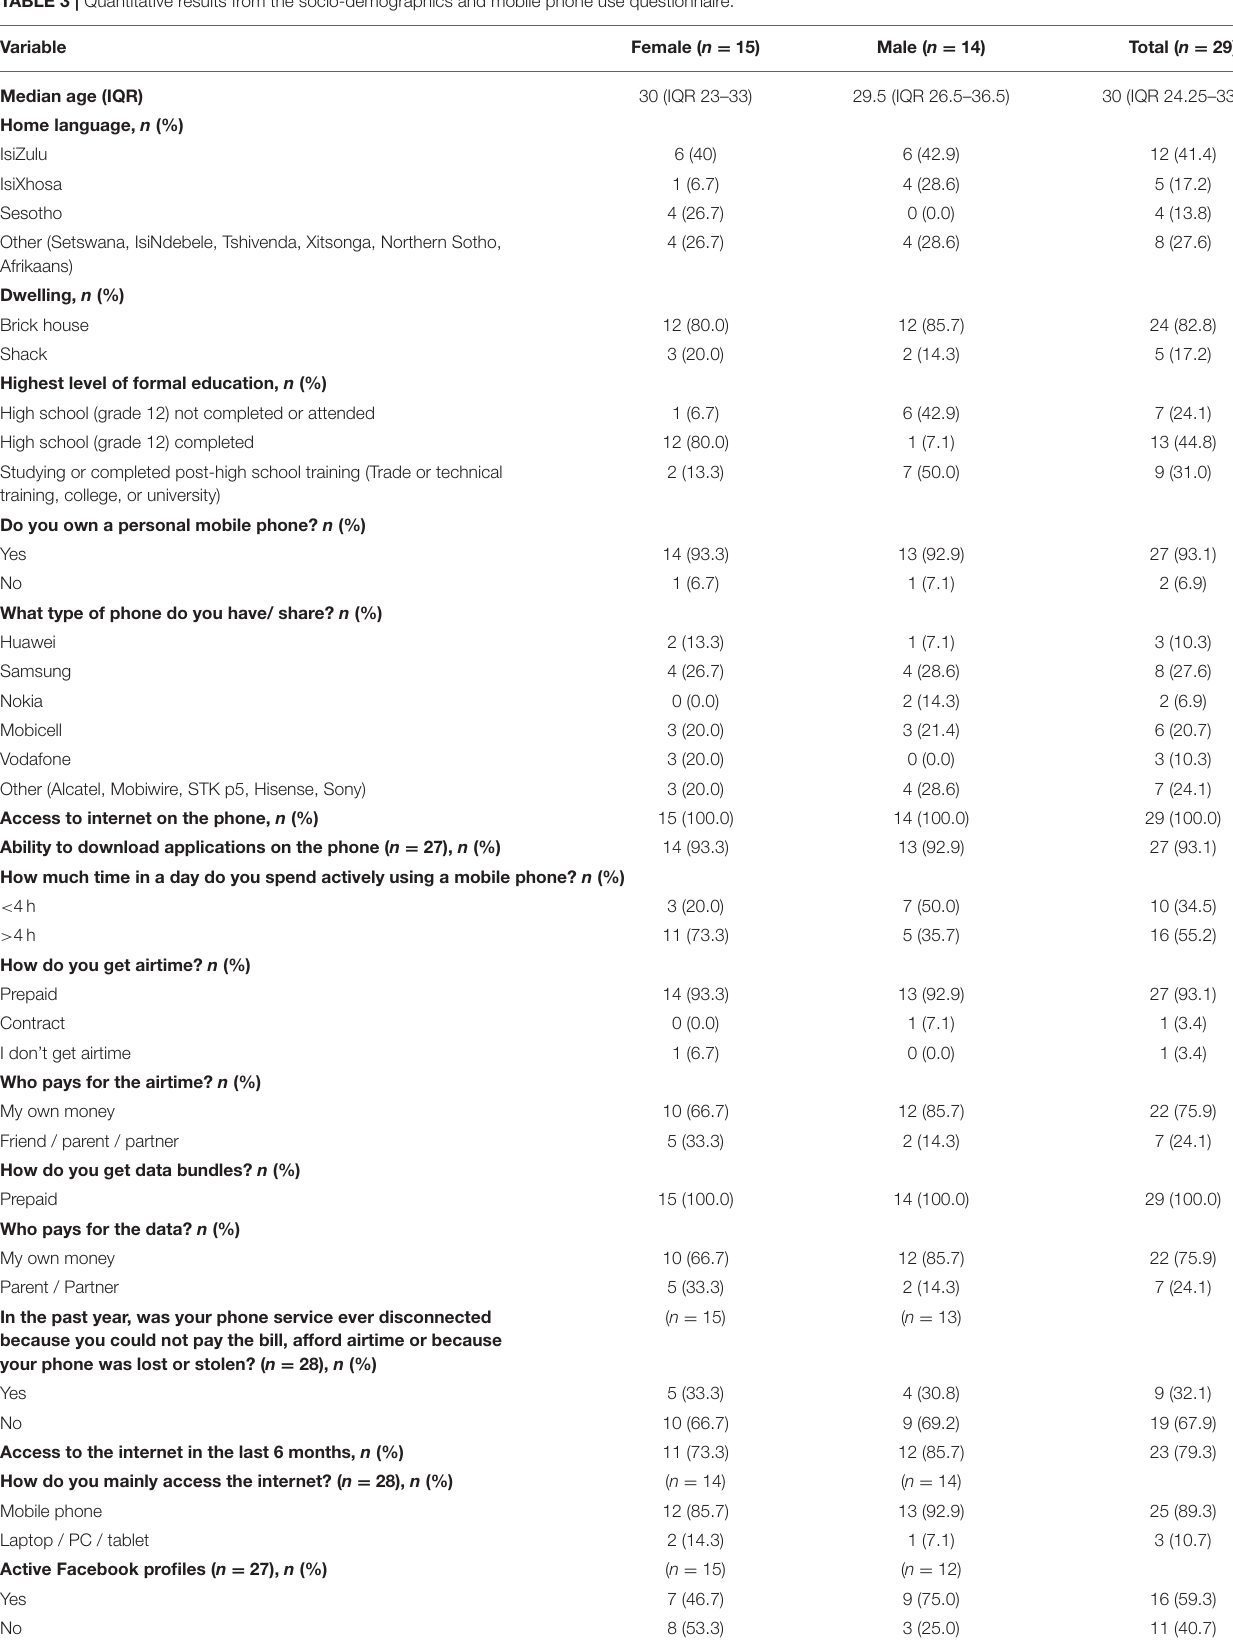
TABLE 3 | Quantitative results from the socio-demographics and mobile phone use questionnaire.